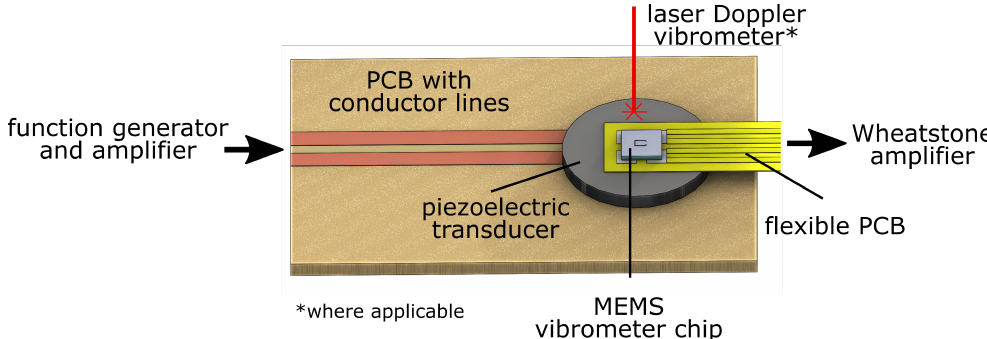
Figure 6. 3D sketch of the test bed for the dynamic sensor response